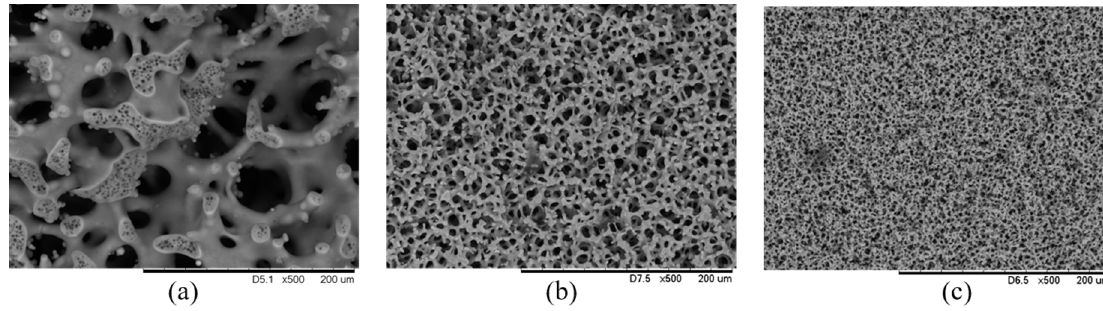
Figure 1. SEM images of ( a ) M1, ( b ) M2, and ( c ) M3 monoliths.